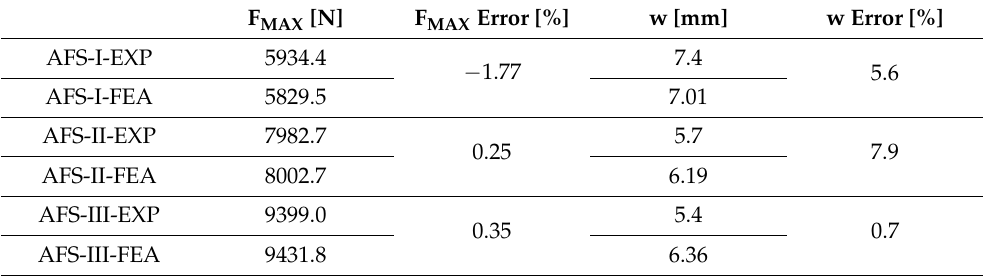
Table 4. Comparison between the repeated impact tests FE results and the experimental